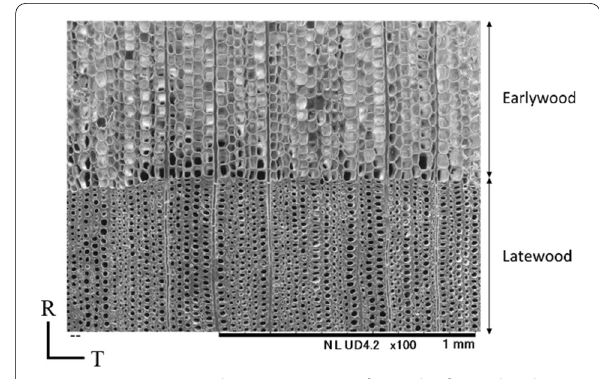
Fig. 5 SEM images on the cross-section of Douglas fir used in this study